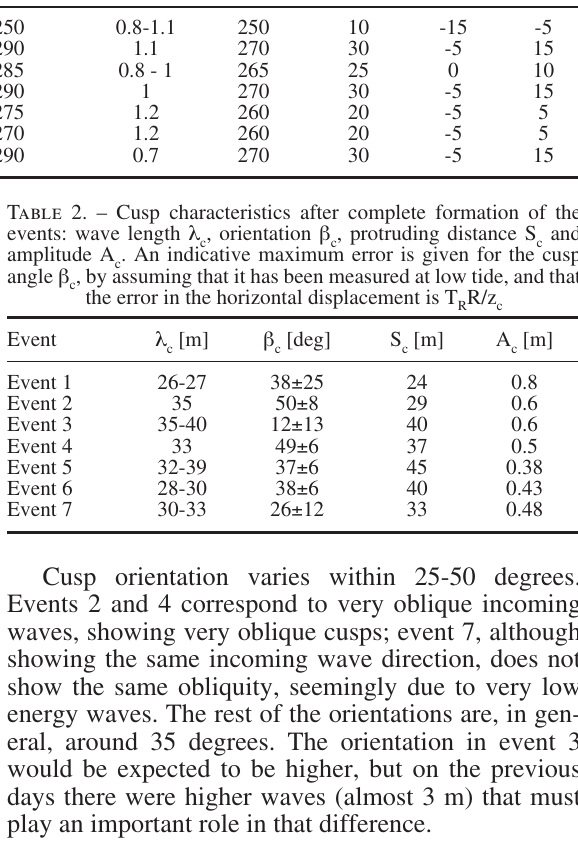
Table 1. – Tidal range and initial wave conditions for the selected events of LBC formation (offshore waves: WANA; nearshore waves: SWAN).